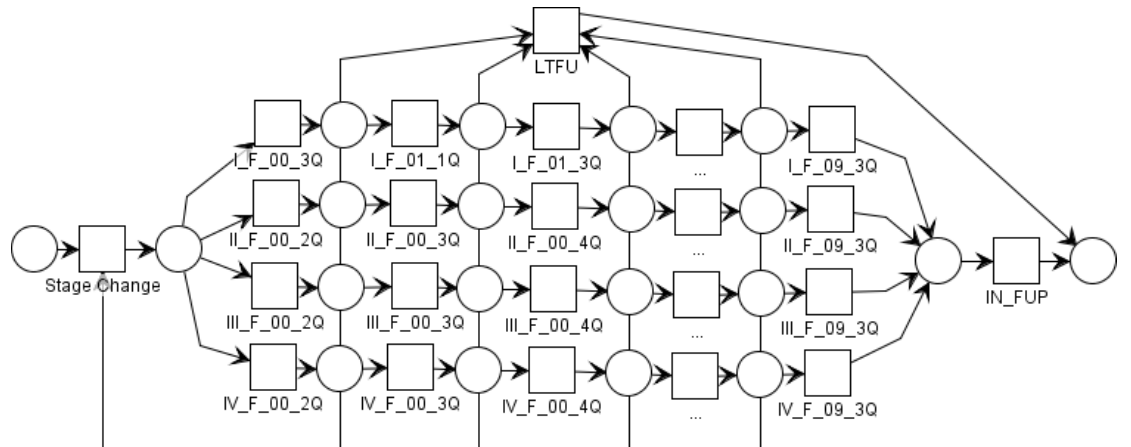
Figure 2. A simplified petri net model with applied time boxing corresponding to the guideline used at the Dermatology at the Medical University Vienna (DDMUV). For each AJCC stage (i.e., I, II, III, and IV) the follow-up visits after three, six, or twelve month (i.e., 2Q is 2nd quarter, 3Q is 3rd quarter, and 4Q is 4th quarter) for ten years are shown. After each follow-up visit a patient can proceed to any later follow-up visit, have a state change, be lost to follow-up (LTFU), or complete the surveillance (i.e., IN_FUP meaning still in follow-up